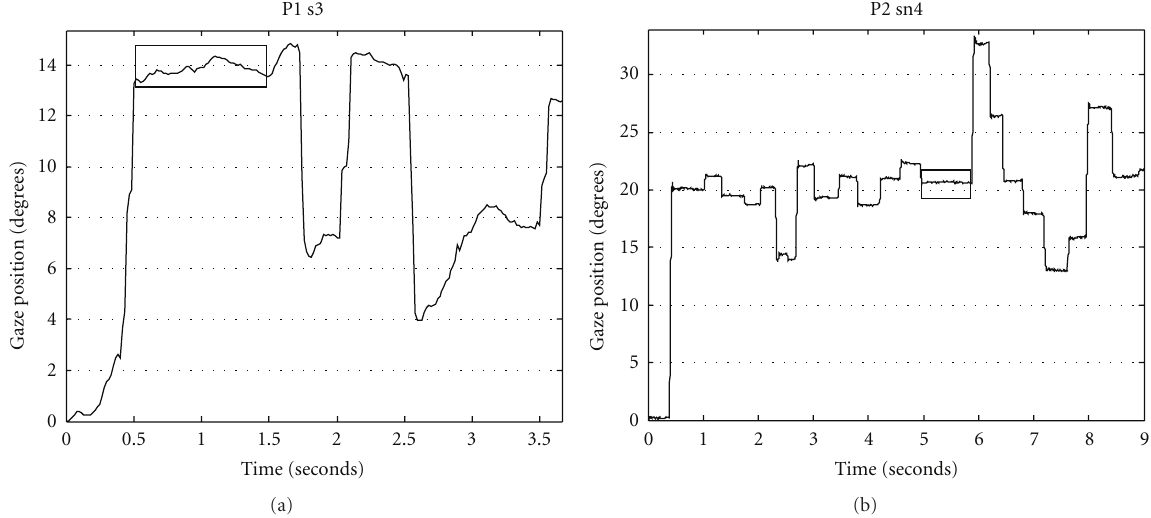
Figure 2: Eye fixation of participant 1 in Exp. 1 (a) and of participant 2 in Exp. 2 (b). For each graph, we show the gaze position signal, which was the average of the two eye position signals in Exp. 1 and one eye position signal in Exp. 2 (in deg) as a function of time (in s). Examples of periods of fixation are emphasized by